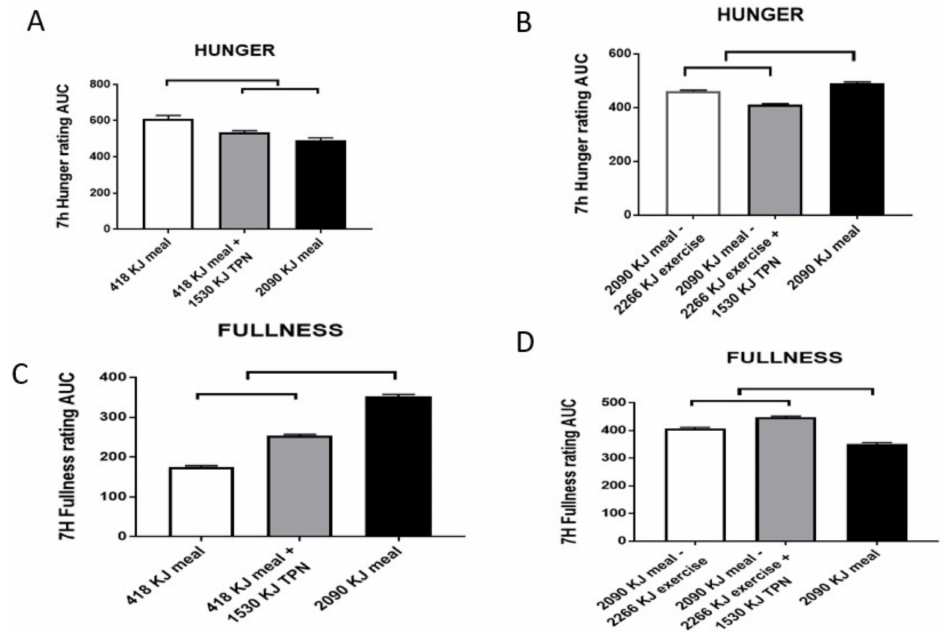
Figure 5. Sensations of hunger ( A , B ) and fullness ( C , D ) in a study comparing the effects of a 418-kJ breakfast, with or without 1530-kJ intravenous nutrient supplementation (total parenteral nutrition (TPN)) to a 2090-kJ breakfast (AL) (A for hunger and C for fullness respectively), or the energy of a 2090-kJ breakfast reduced by 2266 kJ of exercise energy expenditure (EX), with or without TPN supplementation (B and D respectively). Both hunger and fullness are largely unaffected by TPN, whether the energy shortfall is caused by withholding energy in the morning meal (418 vs. 2090 kJ) or by energy expended from the large meal (2090–2266 kJ). The upper bracket indicates significant differences between the trials ( p < 0.001). Data are modified from Borer, Wuorinen, Ku, Burant. Appetite responds to changes in meal content, whereas ghrelin, leptin, and insulin track changes in energy availability. J. Clin. Endocrinol. Metab. 2009, 94, 2290–2298, doi:1210/jc.2008-2495